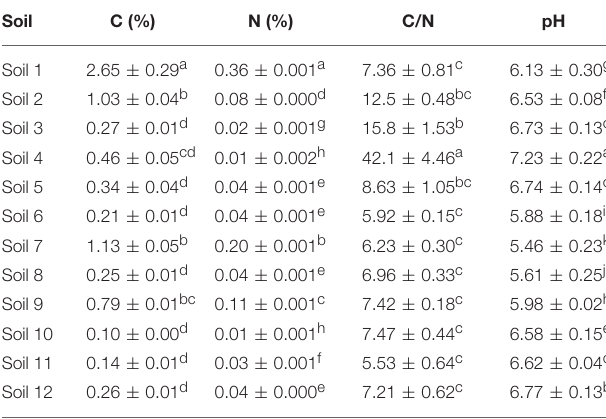
TABLE 1 | Chemical parameters of Antarctic soil